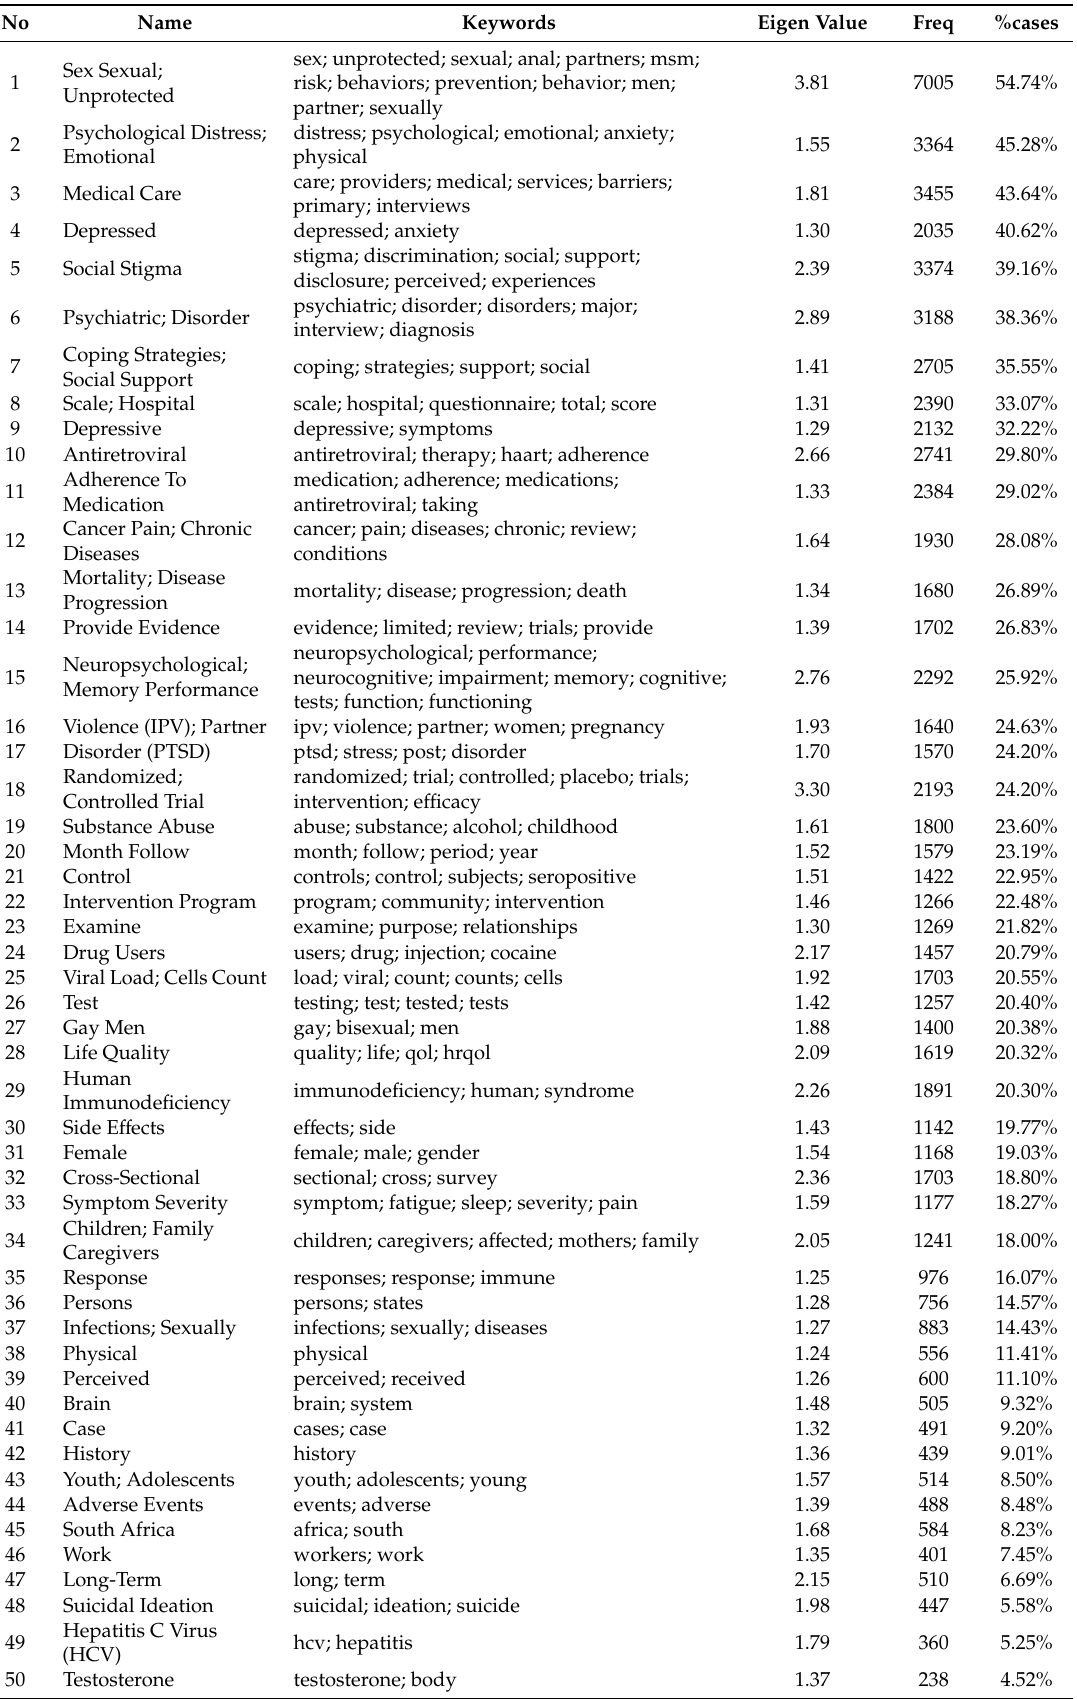
Table 3. Top 50 research domains emerged from exploratory factor analysis of all abstracts’